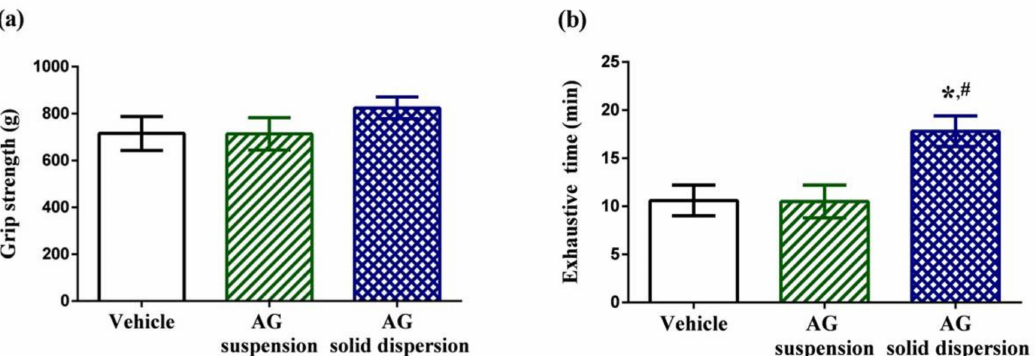
Figure 7. E ff ect of andrographolide (AG) on: ( a ) forelimb grip test; and ( b ) exhaustive swimming test. Data are expressed as mean ± standard deviation ( n = 5 for each group). * Indicates significant di ff erence compared to vehicle group ( p < 0.05). # Indicates significant di ff erence compared to AG suspension group ( p <